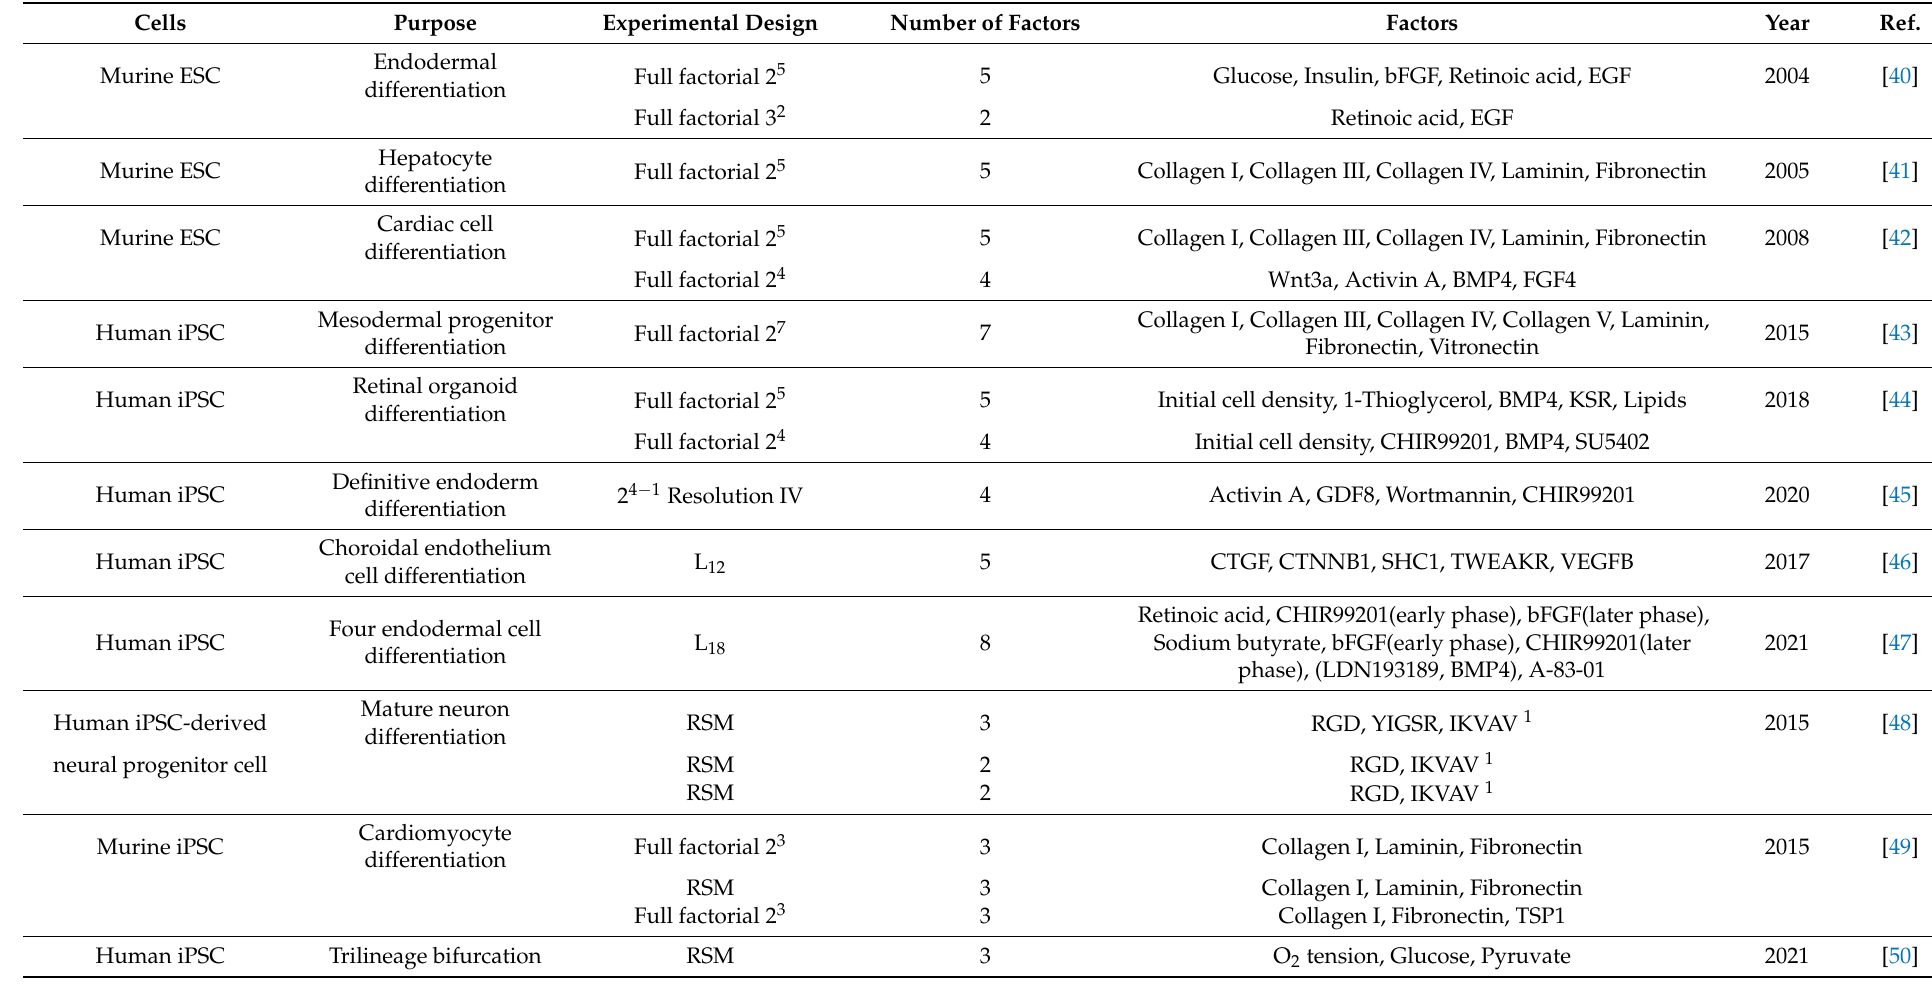
Table 2. DOE studies investigating PSC